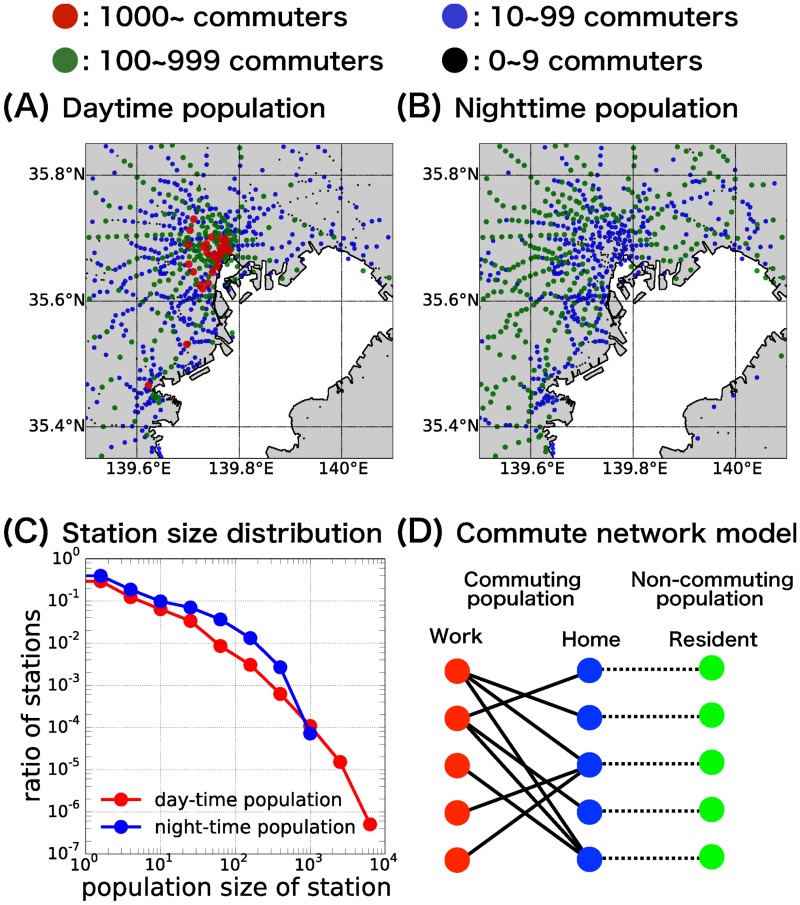
Commute network model of the Tokyo metropolitan area.Geographical distribution of daytime working/studying population (A) and nighttime residing population (B) at each station. Each dot corresponds to a single station, with the color indicating its population size. The red colored stations near the center of (A) corresponds to the inner urban area of the Tokyo metropolitan area, which include the largest working station Shinjuku station, the second largest Tokyo station, and the third largest Shibuya station; the two red stations in the lower left are the Kawasaki and Yokohama stations. The longitude and latitude of each station were acquired from the Station Database [http://www.ekidata.jp]. (C) Population size distribution of the daytime working/studying population (red line) and the nighttime residing population (blue line) at each station. (D) Illustration of the commute network model. Each station has a working/studying area (daytime “work population”, red circles) and a residing area (nighttime “home population”, blue circles) connected by a commuting flow (“commuting population”). The non-commuting population at each station (“resident population”, green circles) is connected to the corresponding home population.